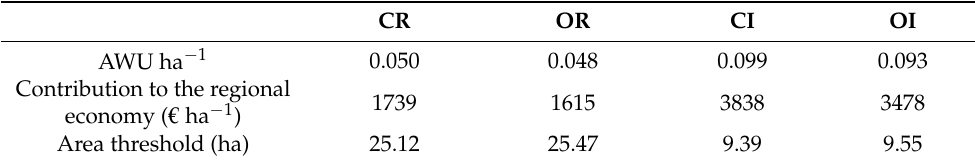
Table 7. Values of the socio-territorial indicators for each